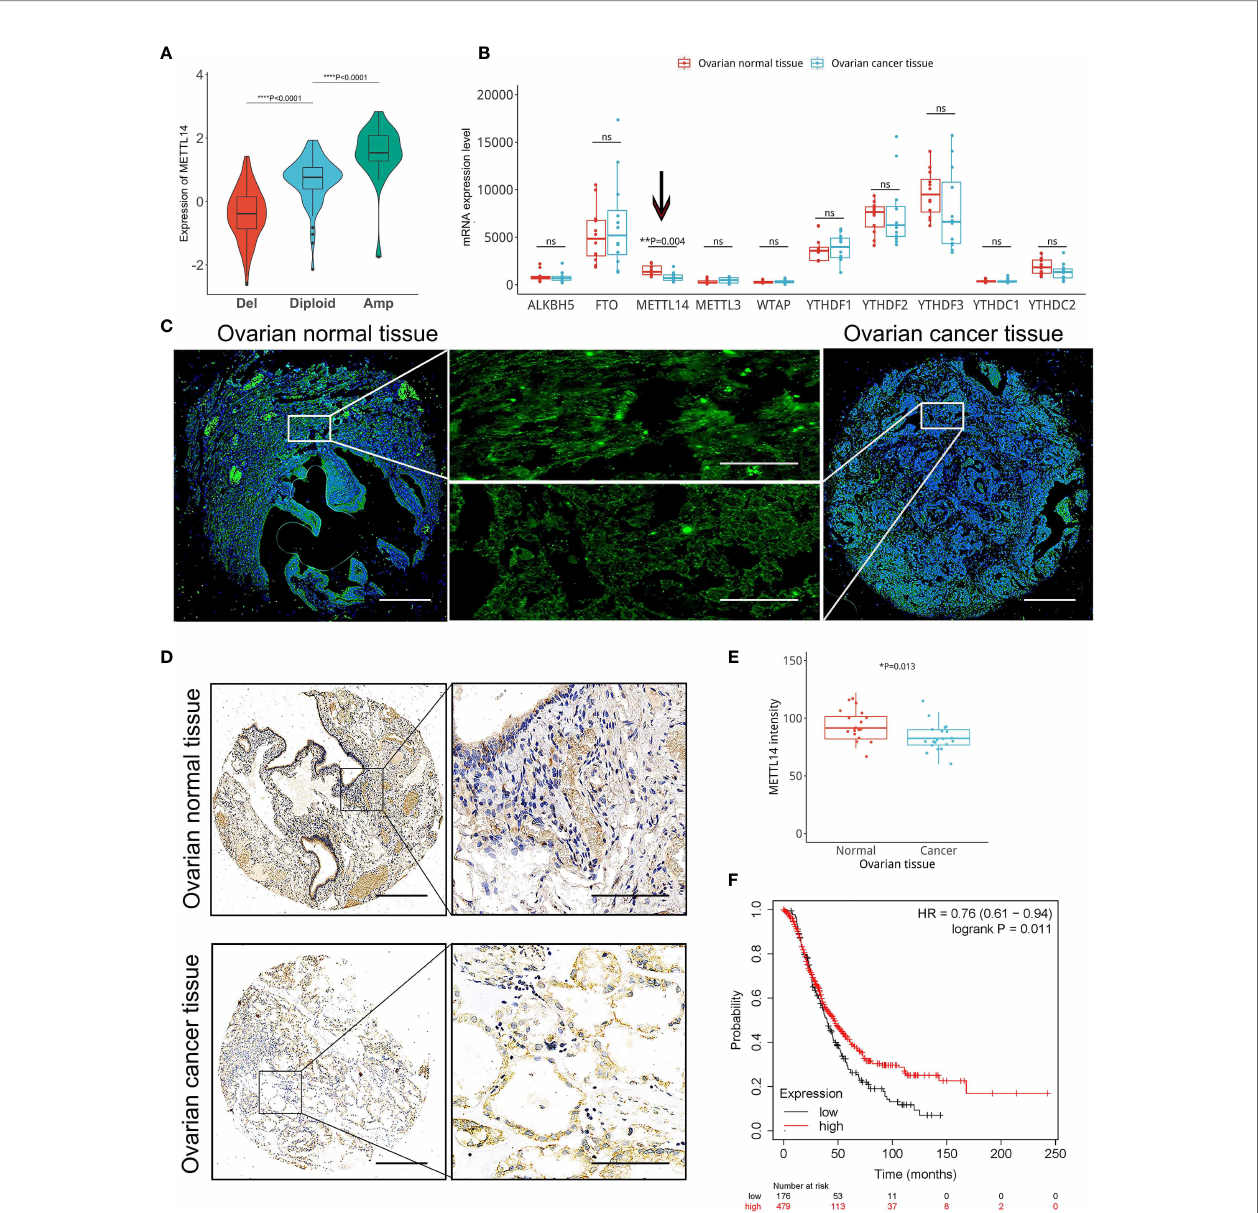
FIGURE 1 | Correlation among reduced METTL14 copy number variations (CNVs) and decreased METTL14 mRNA and protein expression levels in ovarian cancer tissues. (A) The TCGA dataset and available tools were used for the correlation analysis of the METTL14 copy number (deletion, diploid and ampli fi cation) and mRNA expression levels (**** P < 0.0001 by ANOVA). (B) Expression of METTL14 in ovarian cancer tissues vs. normal tissues in the GEO database (GSE14407 with METTL14, probe ID 235552_at, ** P = 0.004). ns, not signi fi cant. (C) FISH images of METTL14 copy numbers in normal and ovarian cancer tissues. Magni fi cation: 50 × (left and right) and 400 × (middle). (D) Immunohistochemistry of METTL14 expression in the tissue microarray of normal and ovarian cancer tissues. Magni fi cation: 50 × (left) and 400 × (right). (E) Summarized data of (D) (* P =0.013). Graphical data represented as the mean ± SD. (F) Kaplan-Meier overall survival curves strati fi ed by METTL14 expression levels in 655 ovarian cancer patients. The mean METTL14 mRNA value was used to assign patients to two subgroups (ID 236060_at). The log-rank test was used to calculate the differences between the two groups (* P =